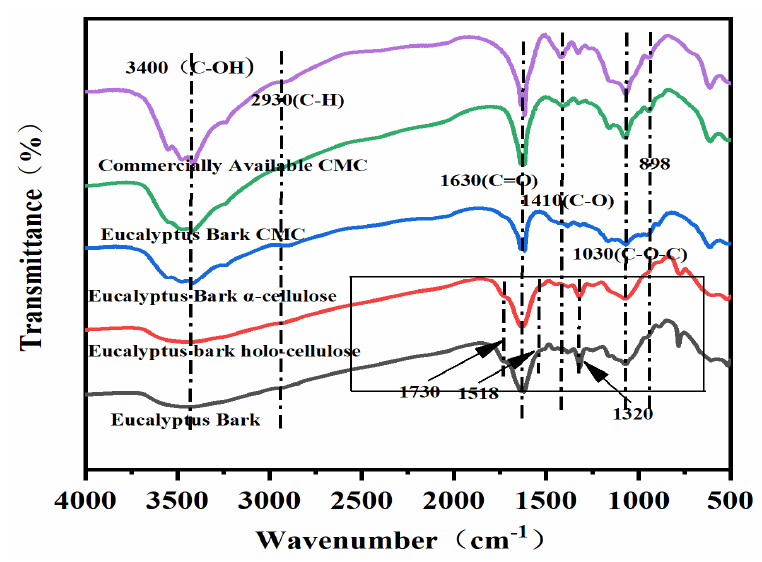
Figure 3. FTIR spectra of bark, holo − cellulose, cellulose, and CMC prepared from eucalyptus bark, as well as commercially available CMC.